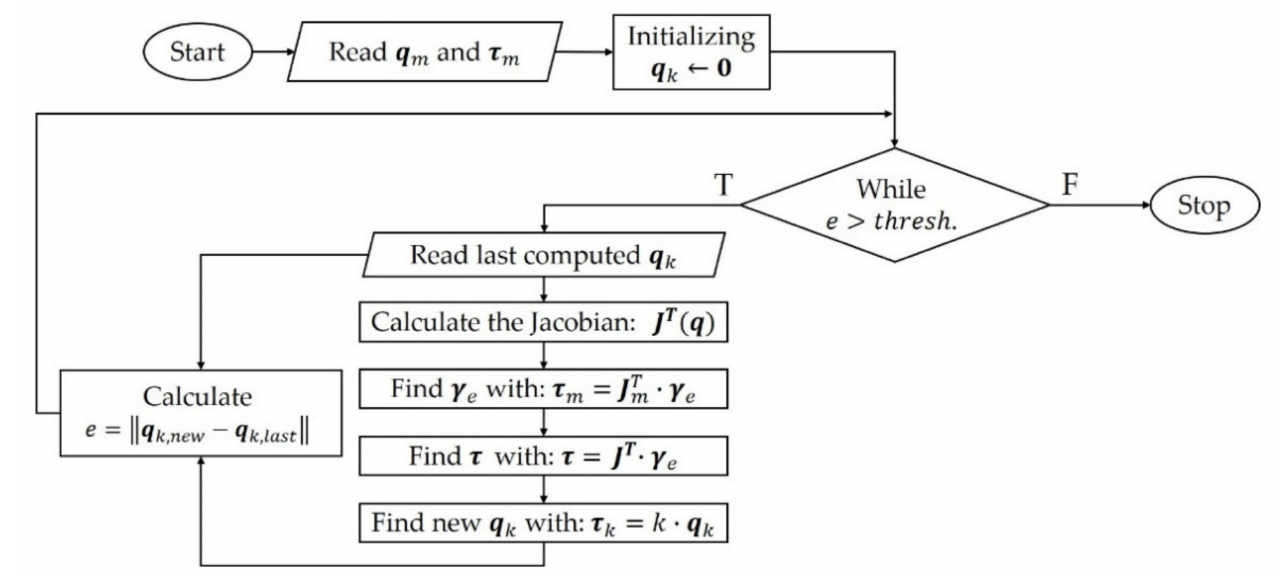
Figure 5. Load and Pose Estimation